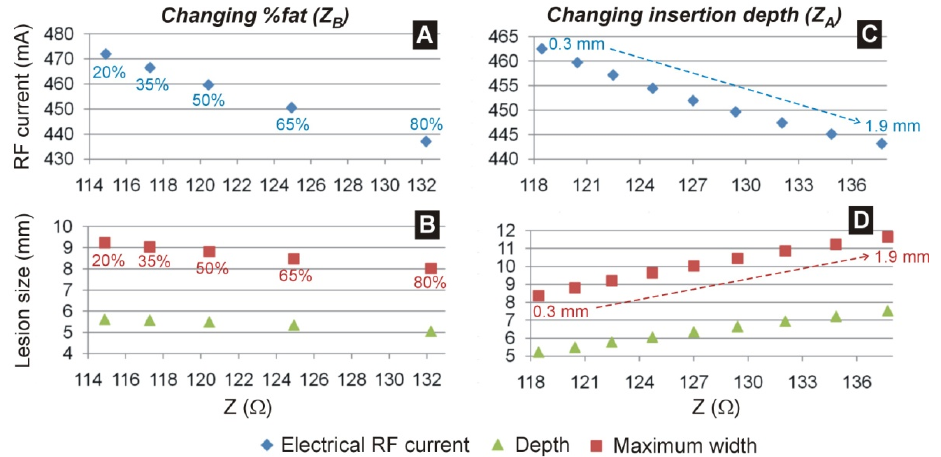
Figure 4. Electrical RF current (at the middle of the RF pulse, 15 s) ( A , C ) and lesion size ( B , D ) for different values of baseline impedance. While in panels ( A , B ) the baseline impedance varied due to the ‘remote’ impedance, specifically the percentage of fat around the organs (from 20 to 80%), in panels ( C , D ) the baseline impedance varied due to the ‘local’ impedance, specifically the electrode insertion depth in the myocardium (from 0.3 to 1.9 mm).